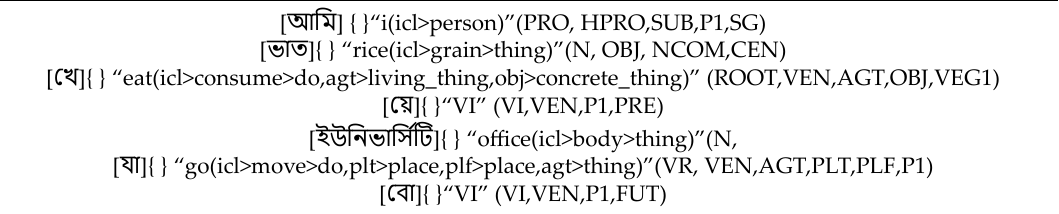
Table 1. Dictionary entries for respective Bangla